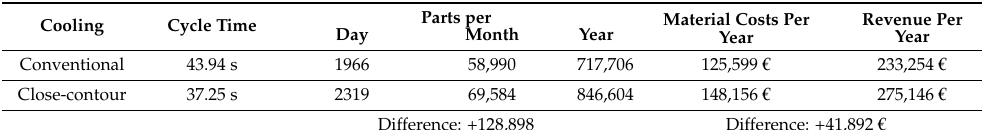
Table 9. Comparison of the productivity rate and the revenue for the initial standard configuration and the optimized close-contour cooling